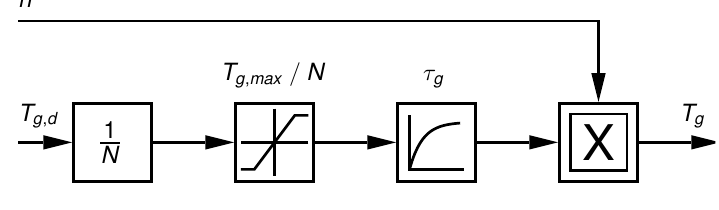
Figure 3. Reduced-order model of multi-generator/converter (Type